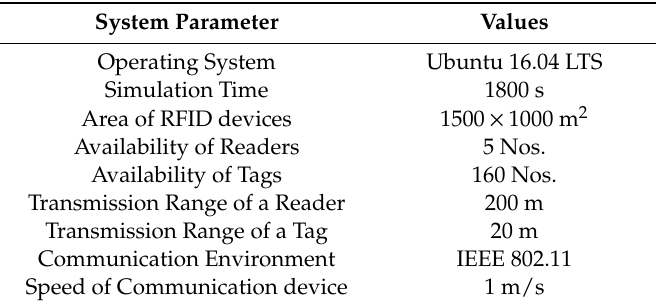
Table 5. Important parameters in NS3